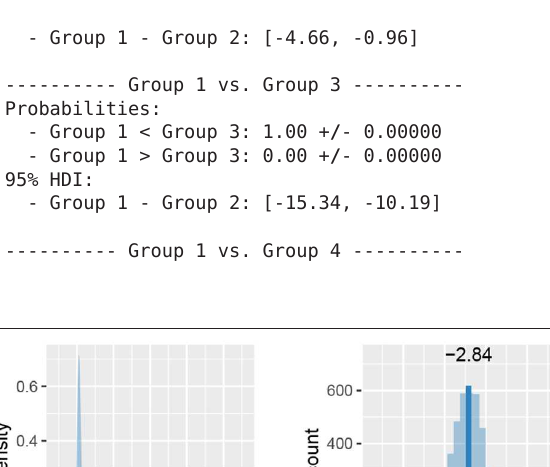
Frontiers in Psychology |